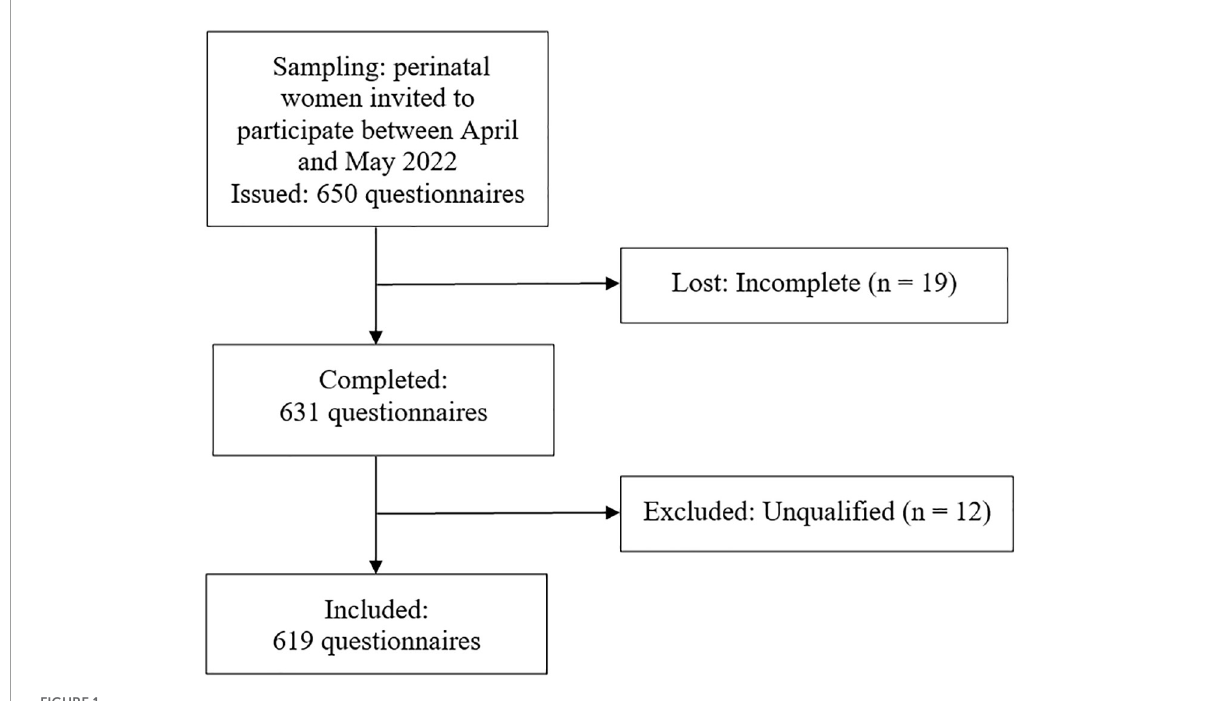
FIGURE1 Flowchart of the data